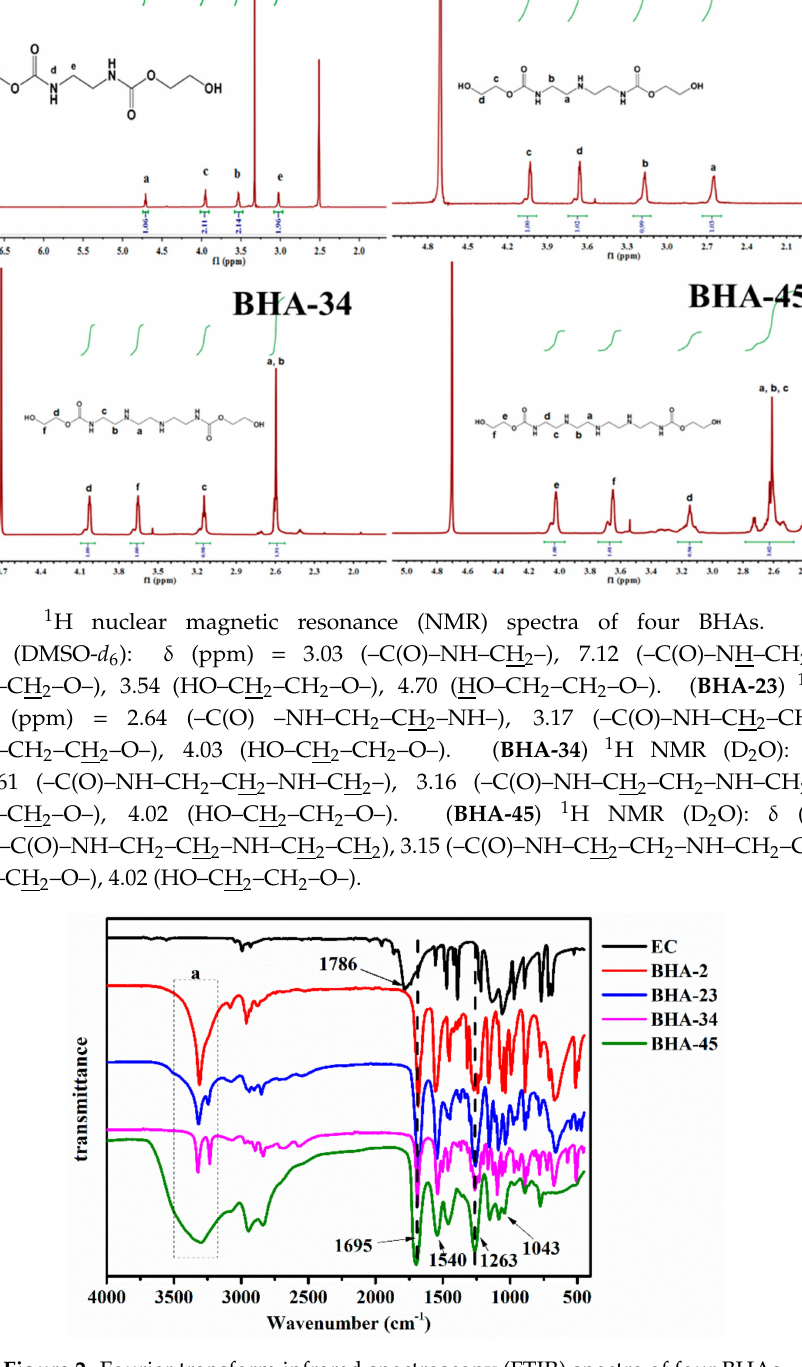
Figure 2. Fourier transform infrared spectroscopy (FTIR) spectra of four